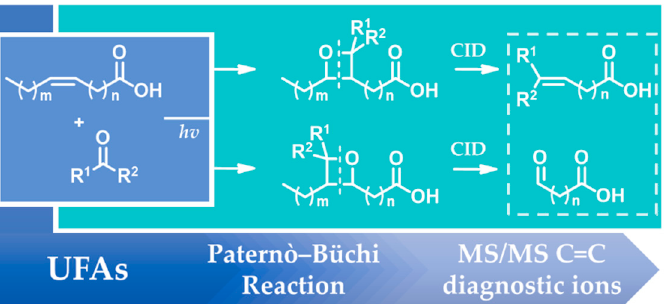
Figure 8. Principle of the combination of the Paternò–Büchi reaction with tandem mass spectrometry (MS/MS) for the determination of the double bond location in UFAs.